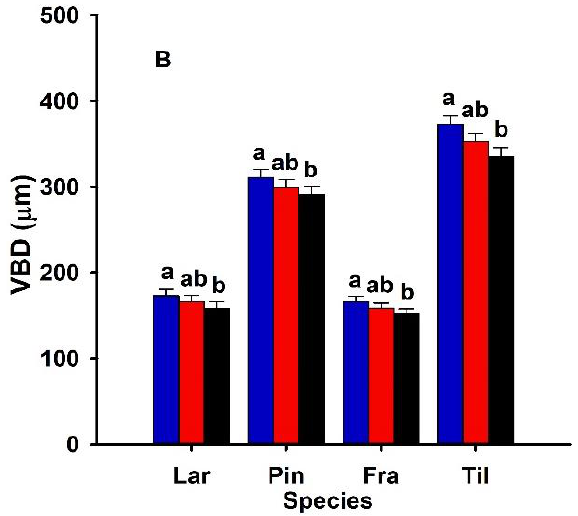
Figure 3. Xylem conduit diameter (XCD; µm) ( A ) and vascular bundle diameter (VBD; µm) ( B ) of two-year-old Larix gmelinii (Lar), Pinus koraiensis (Pin), Fraxinus mandshurica (Fra), and Tilia amurensis (Til) seedlings at three drought levels (i.e., severe drought, SD, ≤ 5%; moderate drought, MD, 6–10%; well-watered, WW, 16–20%). Within species, significant differences between treatments are indicated by different lower-case letters (Tukey’s HSD post hoc; p < 0.05; mean ± SE). Table 2. Anatomical traits of mature, sun-exposed needles/leaves of two-year-old seedlings of Larix gmelinii , Pinus koraiensis (gymnosperms), Fraxinus mandshurica , and Tilia amurensis (an- giosperms), at three drought levels i.e. severe drought, SD, ≤ 5%; moderate drought, MD, 6–10%; well-watered, WW, 16–20% in NE